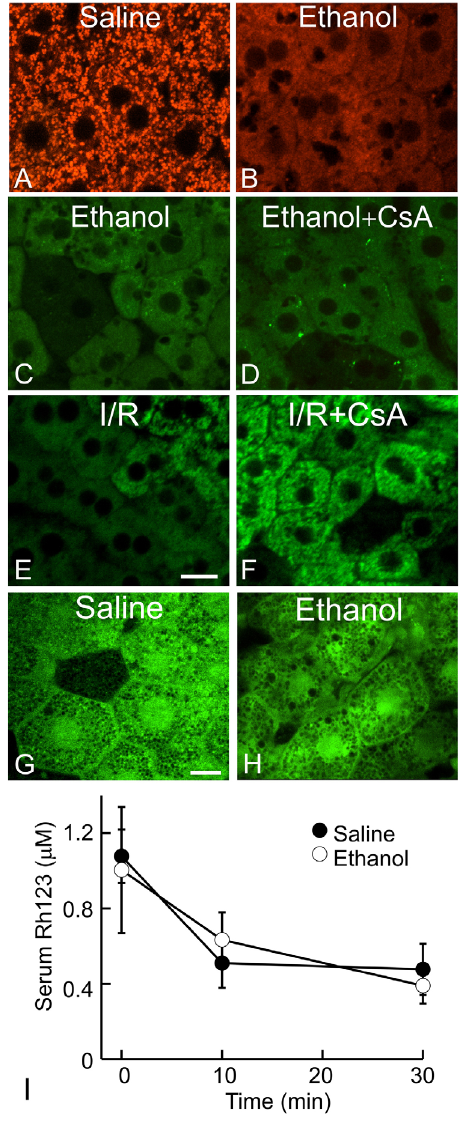
Figure 3. Loss of mitochondrial Rh123 fluorescence after ethanol is unlikely due to upregulation of organic cation transporters, the mitochondrial permeability transition or changes in Rh123 pharmacokinetics. In A–D, G and H, mice were treated with saline or ethanol (6 g/kg, i.g .), and images were collected at 6 h after treatment. In A and B, TMRM fluorescence was detected by intravital confocal microscopy. In C, D, E and F, mice were given vehicle or cyclosporin A (CsA, 10 mg/kg, i.g. ). In E and F, sham-operation and hepatic ischemia/reperfusion (I/R) was performed, and images were collected 2 h later. In C, D, E and F, intravital multiphoton microscopy of Rh123 was performed to detect mitochondrial depolarization. In G and H, calcein fluorescence was imaged. Representative images of 3–4 mice per group are shown. Bars are 10 and 5 m m in E and G, respectively. In I, Rh123 was infused 6 h after saline or ethanol treatment. Blood was collected at 0, 10 and 30 min after Rh123 loading, and serum Rh123 was measured. Serum Rh123 was not significantly different between saline and ethanol-treated mice (n=3 per group).